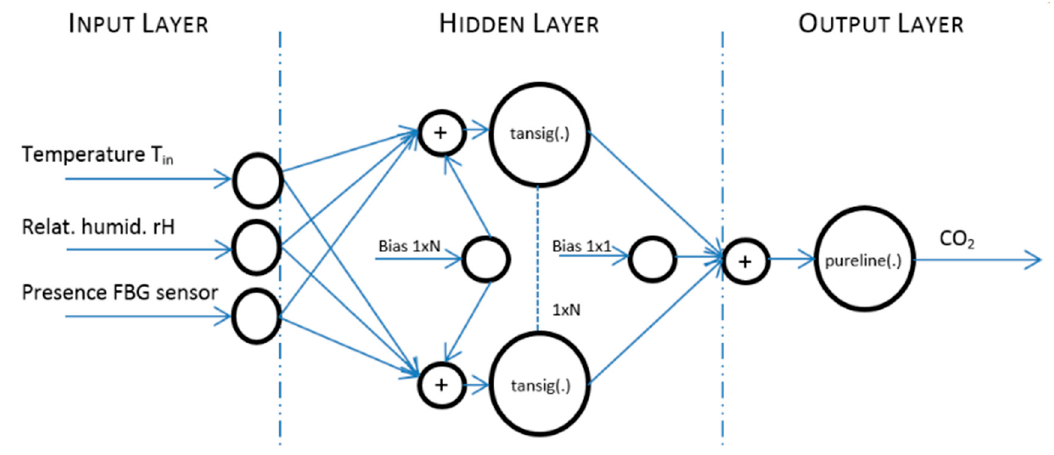
Figure 25. The architecture of designed ANN SCG on test data measured in R203 from 25 June 2018 for three inputs T in , rH in and those of an FBG sensor for PPM. Table 5. Learned ANN SCG from 25 June 2018 in R203 (with T in, rH in and an FBG sensor for PPM) and prediction with cross-validation for 26 June 2018 in R203 (with T in, rH in and an FBG sensor for PPM), 27 June 2018 in R203 (with T in, rH in and an FBG sensor for PPM), 28 June 2018 in R203 (with T in, rH in and an FBG sensor for PPM).